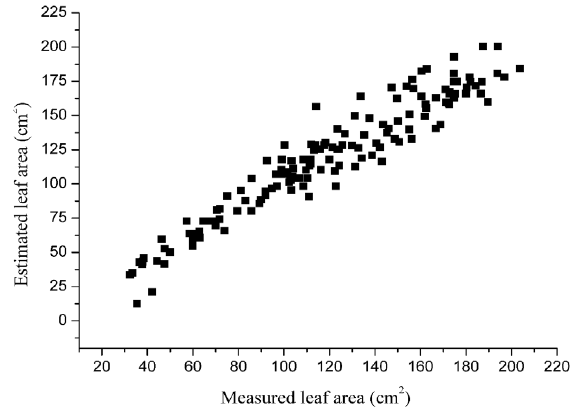
Figure 5 - Dispersion of data between the measured leaf area (cm 2 ) and the estimated leaf area (cm 2 ) using the function LA = -69.9346 + 15.0106L + 0.188931K - 0.0264323H in cassava leaves, cultivar IAC 576-70, at 80 days after planting in the region of Botucatu, SP, Brazil. (LA = leaf area; L = lobe length; K = lobe length x lobe width; H = lobe length x lobe width x number of